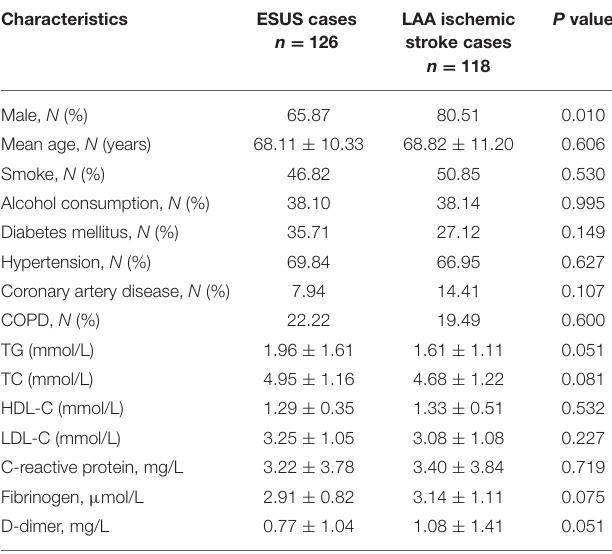
TABLE 1 | Baseline characteristics.